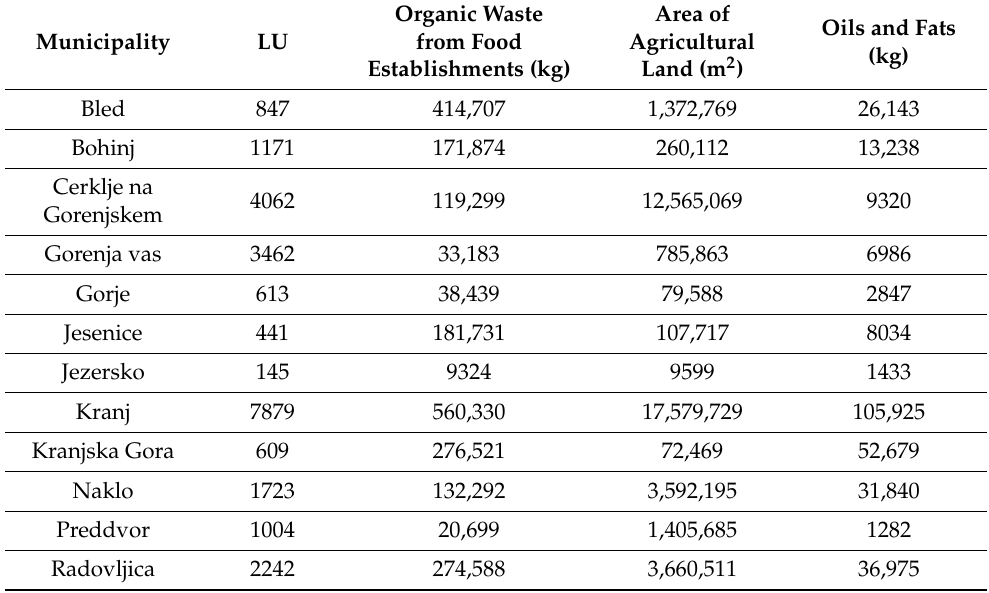
Table 1. Amounts of LU and waste by municipalities